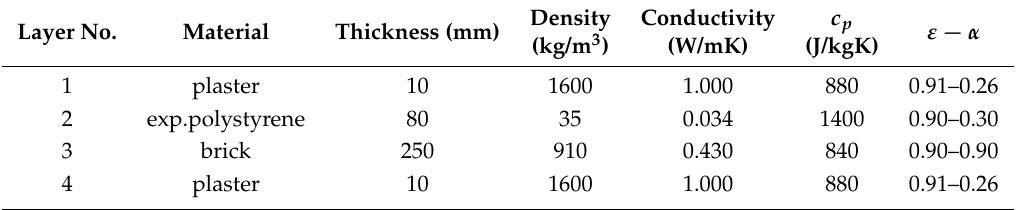
Table A1. Case A: externally-insulated wall, “PTC” (Layer 1 is outdoors). Thickness: 350 mm. Layer No.